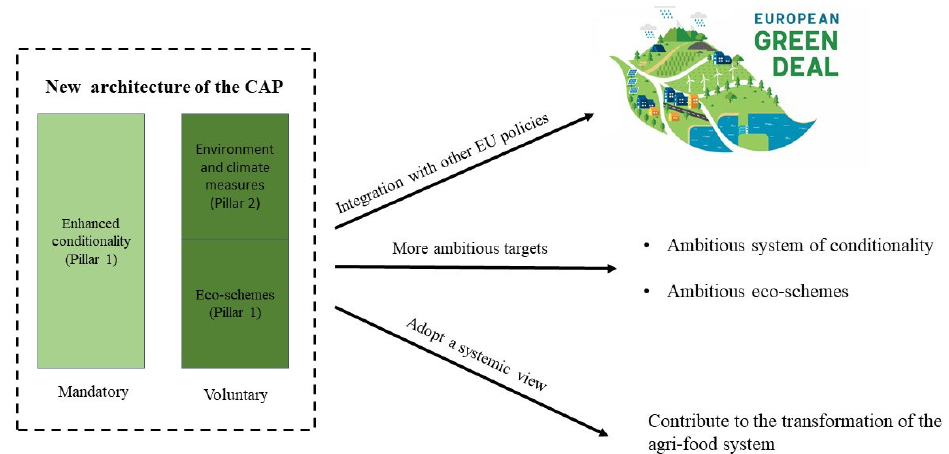
Figure 6. The three challenges related to the new architecture of the European Common Agricultural Policy (CAP). Authors’ elaboration based on the cited literature.